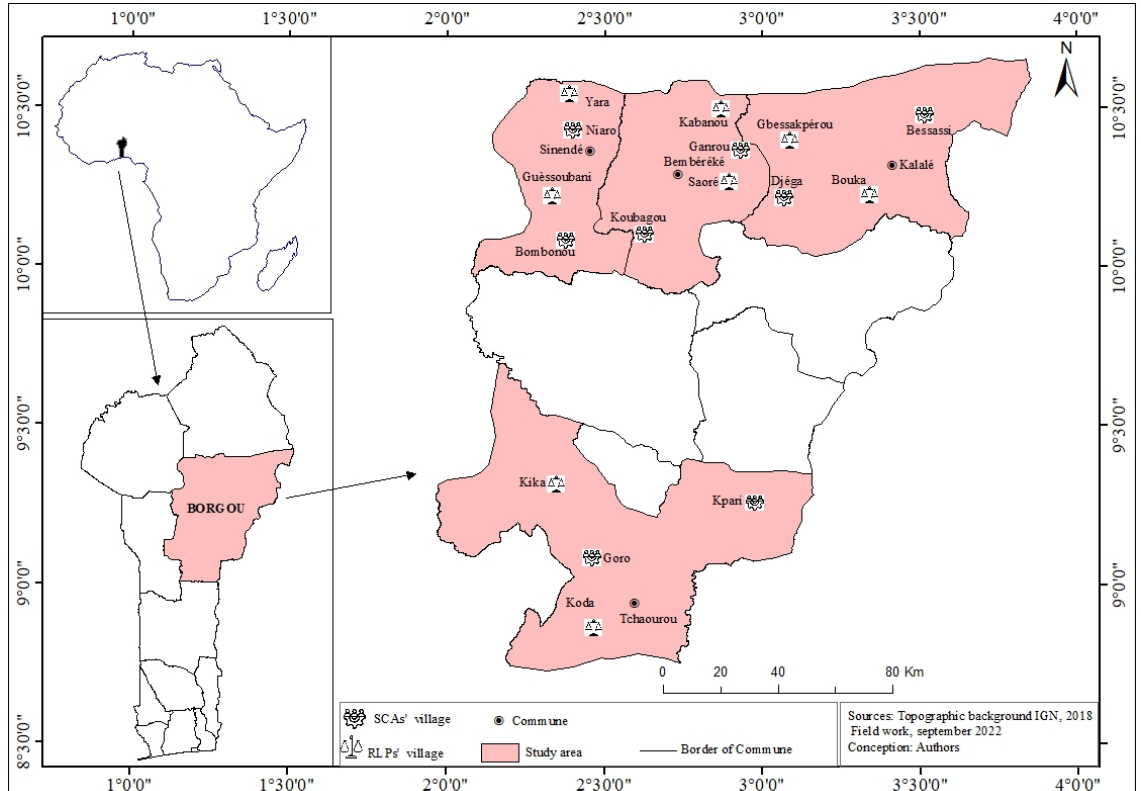
Figure 1. Presentation of research areas.